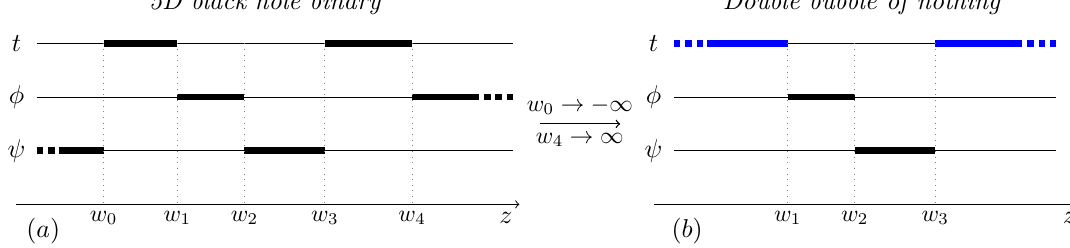
Figure 7 . ( a ) Rod diagram for the five-dimensional black hole binary of [31]. ( b ) Limit to the expanding bubble of nothing of section 4.7 in [3], which is asymptotic to a space compactified on a two-torus. The space in between the horizons, w 1 < z < w 3 , consists of two topological disks D 2 , orthogonal to each other and touching at their origins (at extension, these become two orthogonal S 2 that touch at their